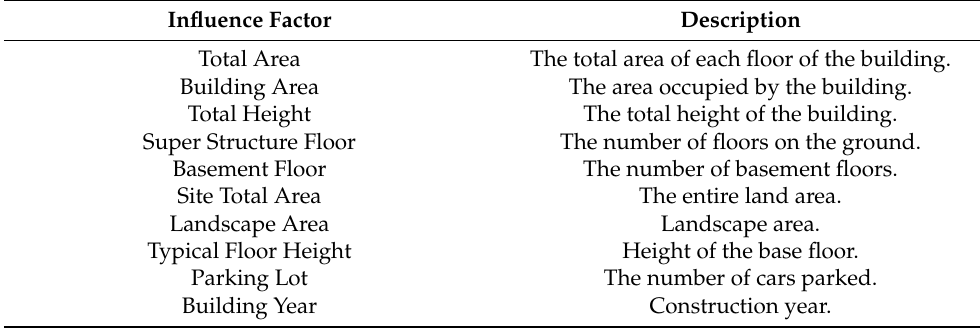
Table 3. Factors influencing construction costs